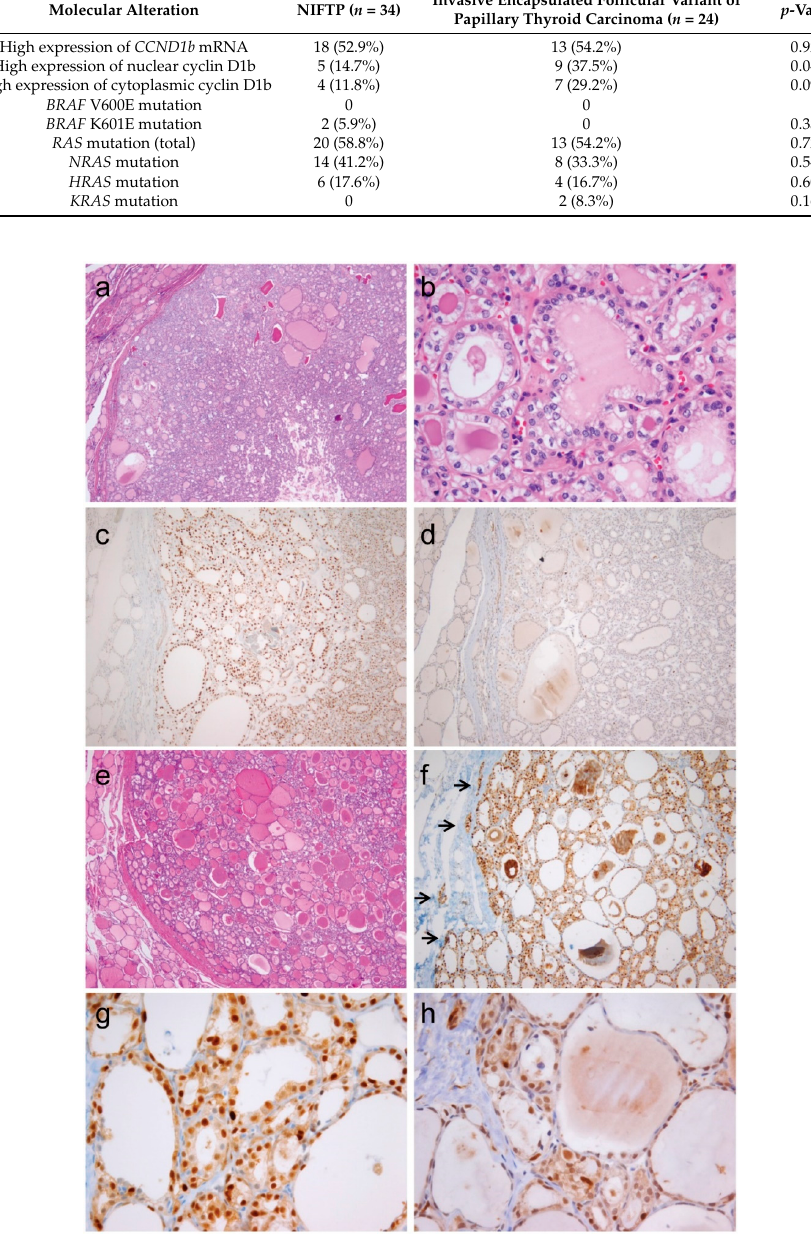
Figure 5. Immunohistochemistry for cyclin D1a and cyclin D1b in noninvasive follicular thyroid neoplasm with papillary-like nuclear features ( a – d ) and invasive encapsulated follicular variant of papillary thyroid carcinoma ( e – h